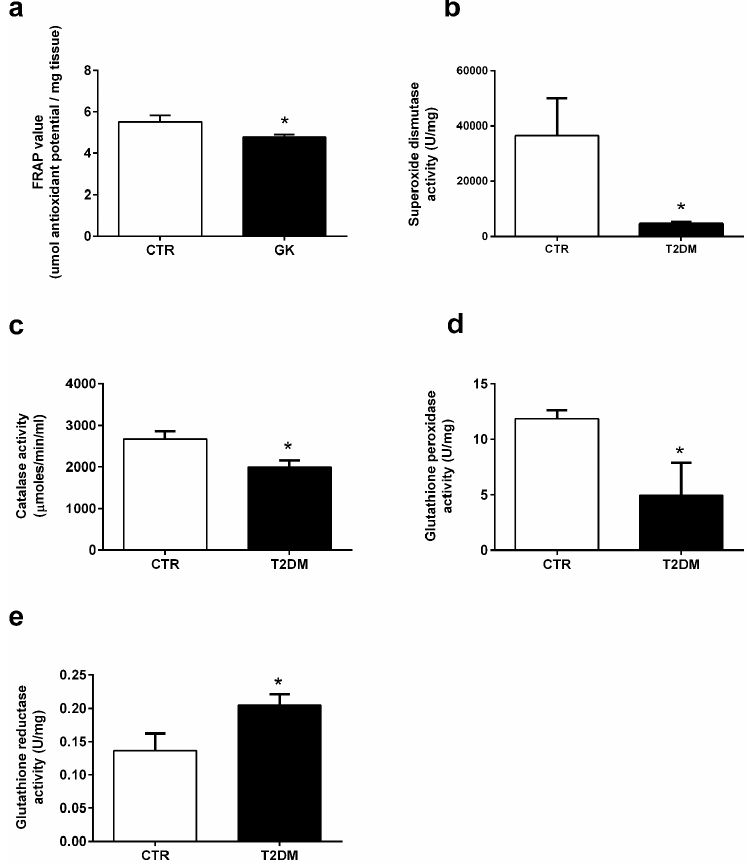
Figure 4. Activities of the antioxidant enzymes ( a ) antioxidant capacity; ( b ) superoxide dismutase, ( c ) catalase, ( d ) glutathione peroxidase, and ( e ) glutathione reductase in the epididymal tissue from the control and T2DM groups. Number of animals per group: 7 in control group and 7 in T2DM group. Results are presented as mean ± SEM of three independent experiments. Significantly differ- ent results ( p < 0.05) are indicated: * relative to control.